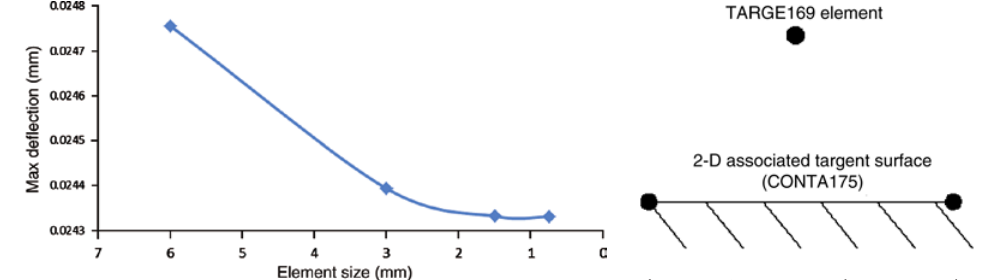
Figure 3: CONTA175 and TARGE169 elements.